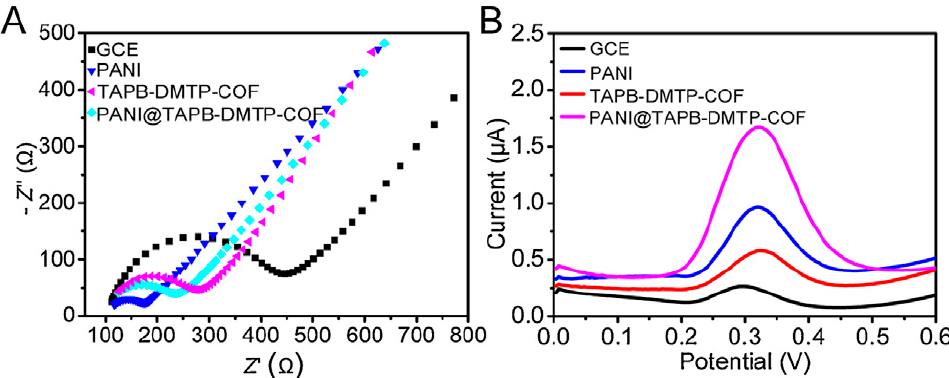
Figure 4. ( A ) EIS Nyquist plots and ( B ) Differential pulse voltammetry voltammograms of bare GCE, PANI/GCE, TAPB-DMTP-COF/GCE, and TAPB-DMTP-COF@PANI/GCE from Ref. [73]. Copyright 2021 Elsevier.